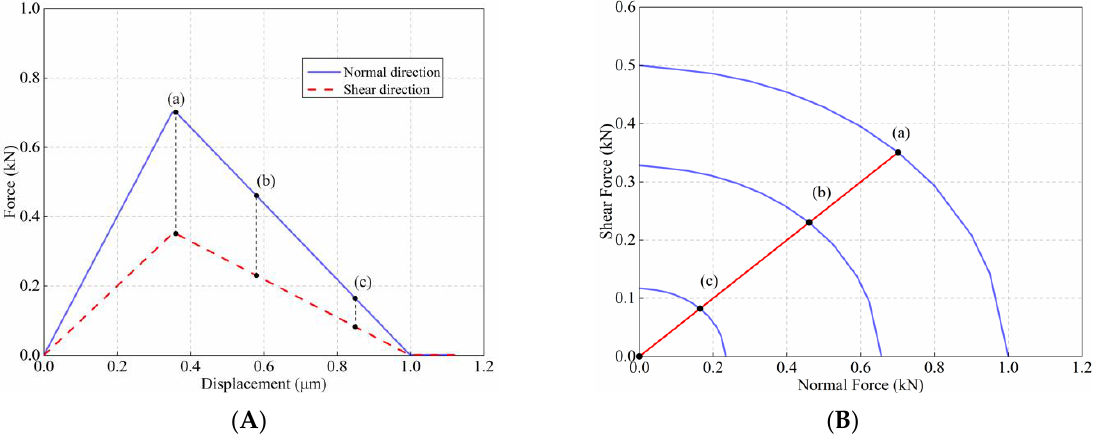
Figure 10. ( A ) Force – displacement relationship in normal and shear direction; ( B ) the evolution of force states as the yield surface shrinks.